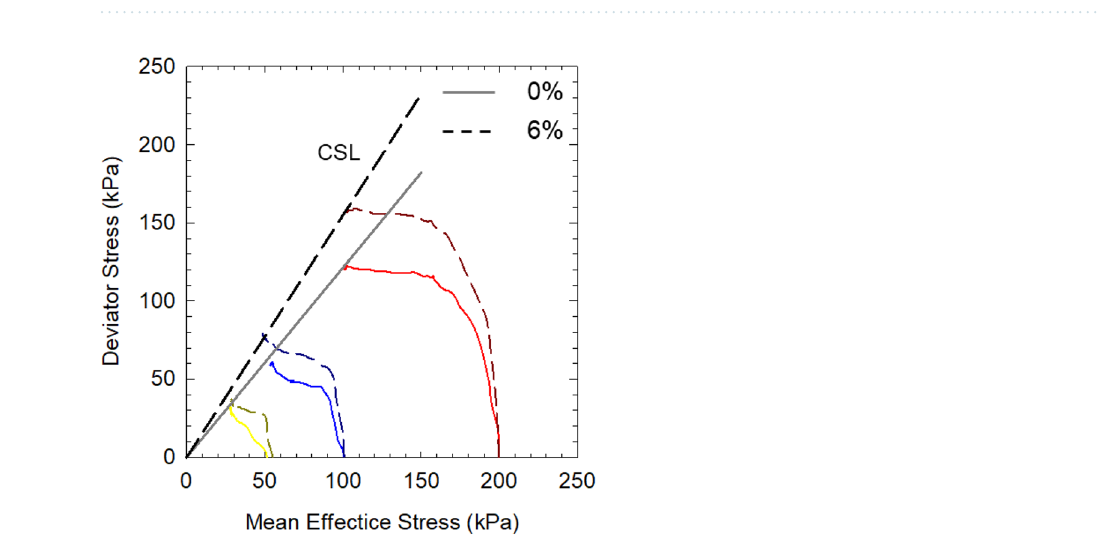
Figure 5. Effective stress path of soft marine clay with porewater salinity at ( a ) S = 0%; ( b ) S = 2%; ( c ) S = 4%; ( d ) S = 6%.